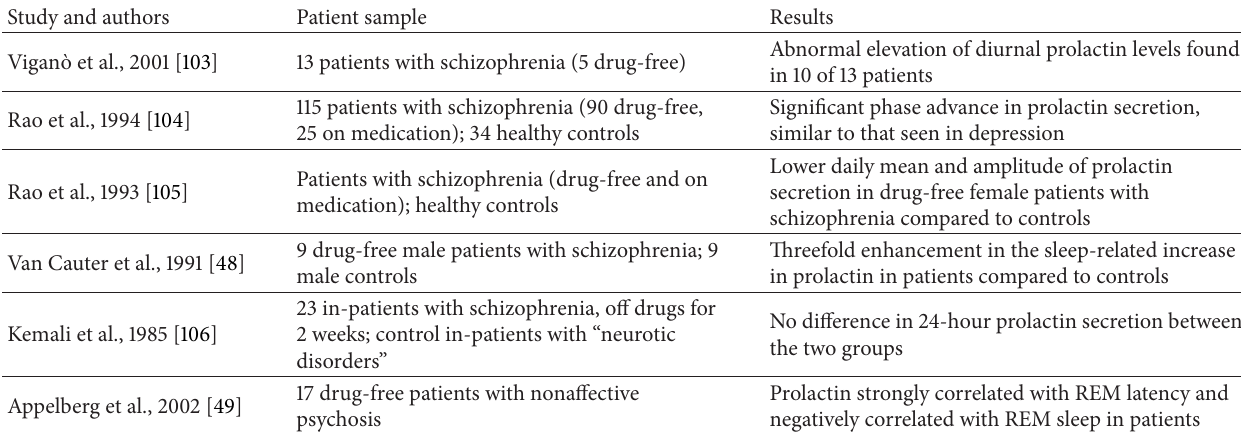
Table 6: Studies of prolactin and circadian rhythm in